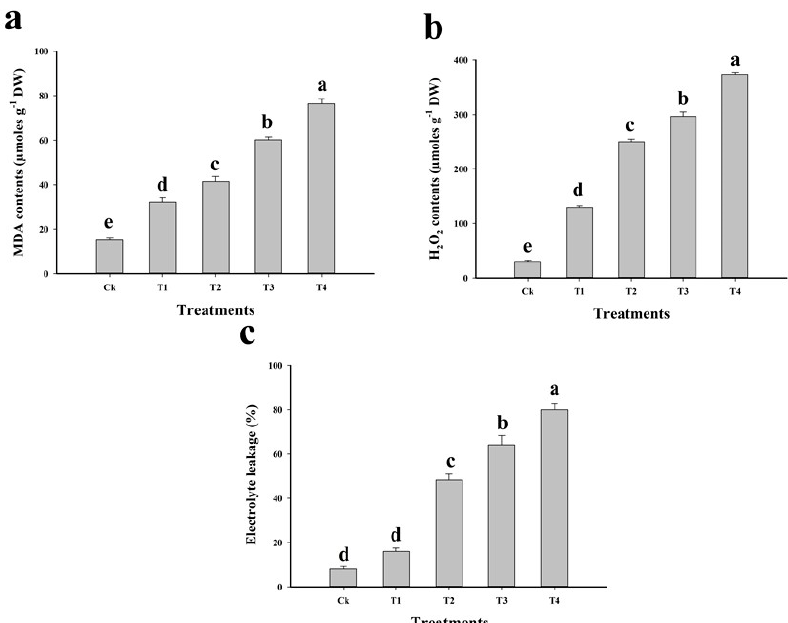
Figure 3. E ff ect of di ff erent levels of Cu-contaminated soil mixed with natural soil on malondialdehyde (MDA) contents ( a ), H 2 O 2 contents ( b ) and electrolyte leakage ( c ) in the leaves of C . capsularis . Values in the figures are just one harvest. Bars sharing di ff erent lowercase letters denote significant statistical di ff erences among the treatments at p < 0.05 according to least significant di ff erence (LSD) test. Data shown are the average of three replications ( n = 3). Ck (soil without addition of Cu-contaminated soil), T1 (Cu-contaminated soil is mixed with natural soil by 1:4), T2 (Cu-contaminated soil is mixed with natural soil by 1:2), T3 (Cu-contaminated soil is mixed with natural soil by 1:1) and T4 (Cu-contaminated soil is mixed with natural soil by 1:0).